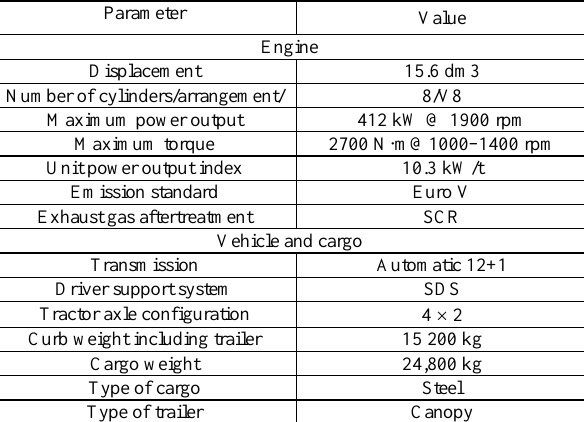
Table 2. Characteristics of vehicles used for the tests Parameter